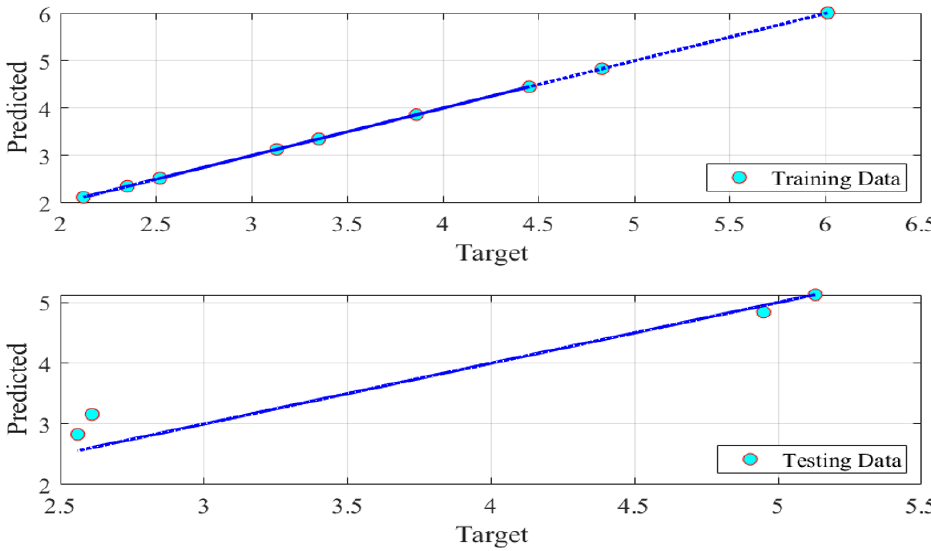
Figure 5. Fuzzy model prediction accuracy of the CO 2 capture process.